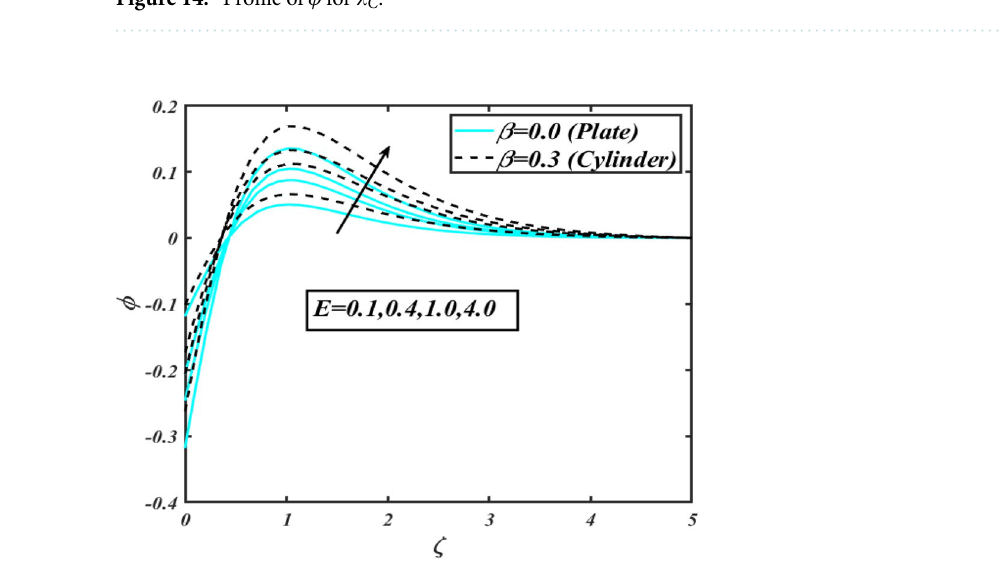
Figure 15. Profile of φ for E .